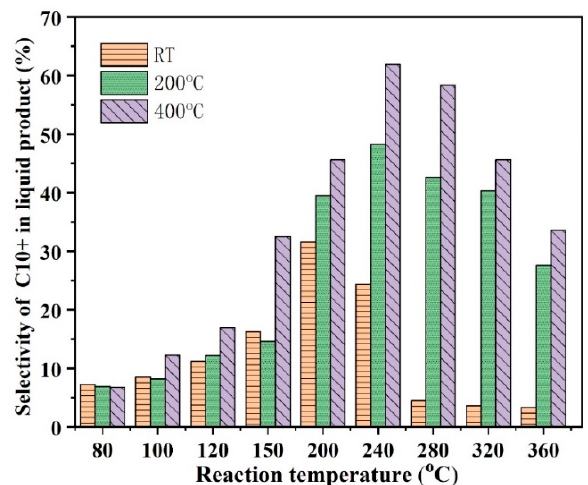
Figure 11. C 10 + product of ethylene oligomerization catalyzed by Ni / Si-Al (7.7, RT) activated at 200 and 400 °C, respectively. Reaction conditions: pressure: 3.5 MPa; WHSV: 2.0 h − 1 ; Ni precursor: Ni(NO 3 ) 2 ; aging temperature: room temperature.